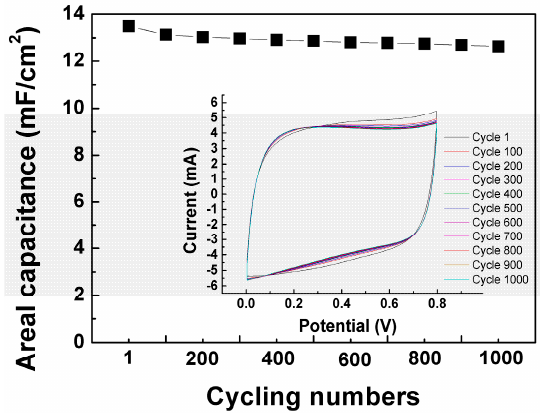
Figure 9. CV stability result of gel-electrolyte supercapacitor with one APPJ scan.